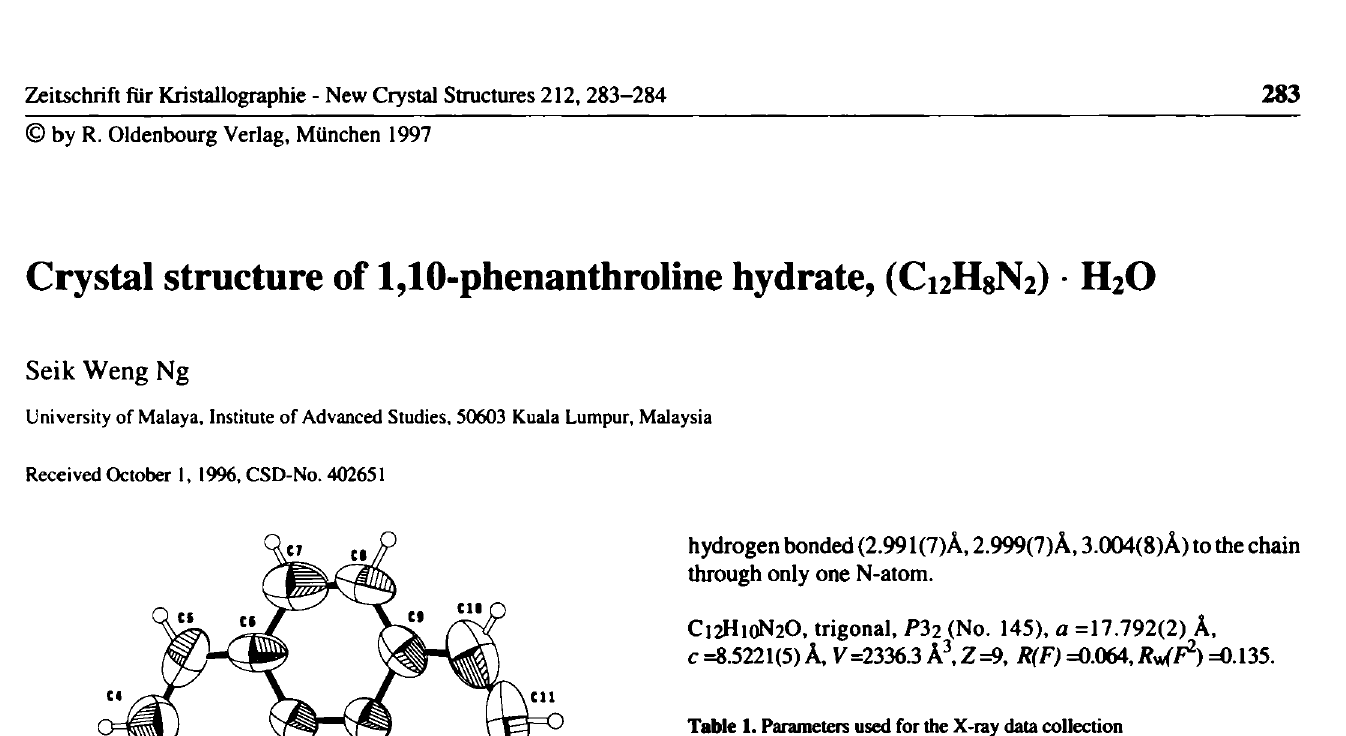
Table 1. Parameters used for the X-ray data collection